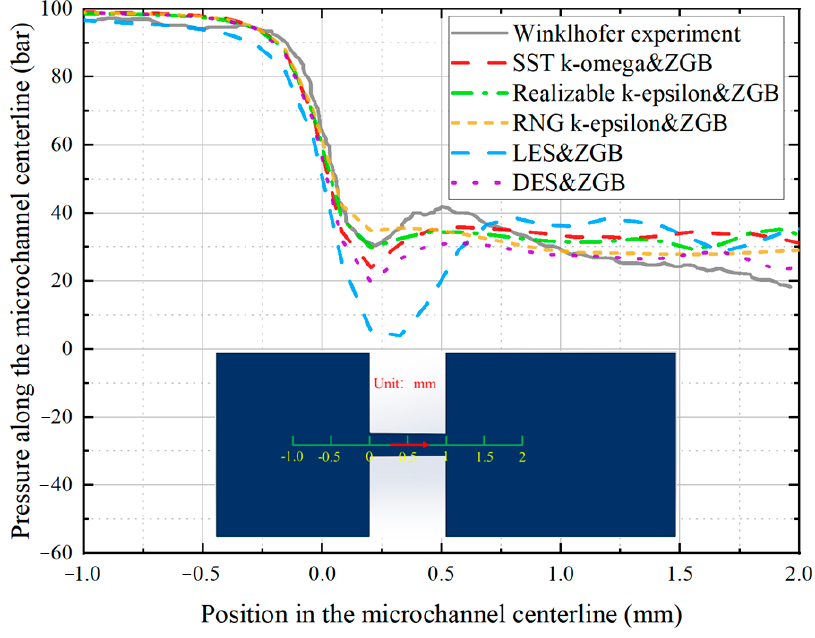
Figure 5. Comparison of the pressure gradient results at the centerline of the model under different turbulence models. Table 3. Comparison of the error of the simulated average value of pressure gradient for each model combination with the experimental